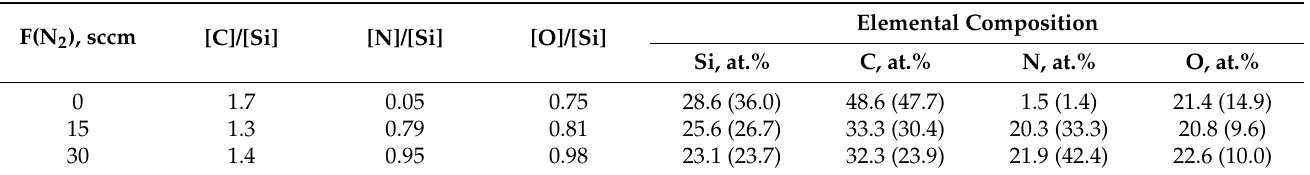
Table 6. Atomic ratios of elements and elemental composition of SiC x N y films * from the XPS measurement. The EDX data are given in parentheses.